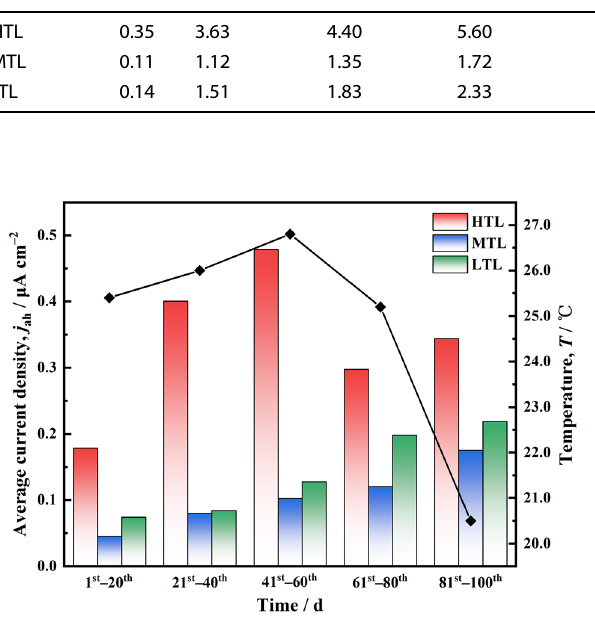
Fig. 9 Average hydrogen permeation current density ( j ah ) of the AISI 4135 steel samples and the ambient temperature for different exposure time periods. These average data were calculated for the data collected from the electrochemical hydrogen permeation test conducted from 6 July to 12 October